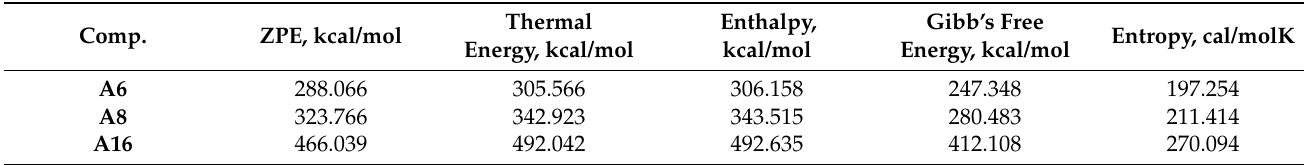
Table 2. ZPE, thermal energy, enthalpy, Gibb’s free energy and entropy of the series An at room temperature calculated at B3LYP/6-311g(d,p) level.